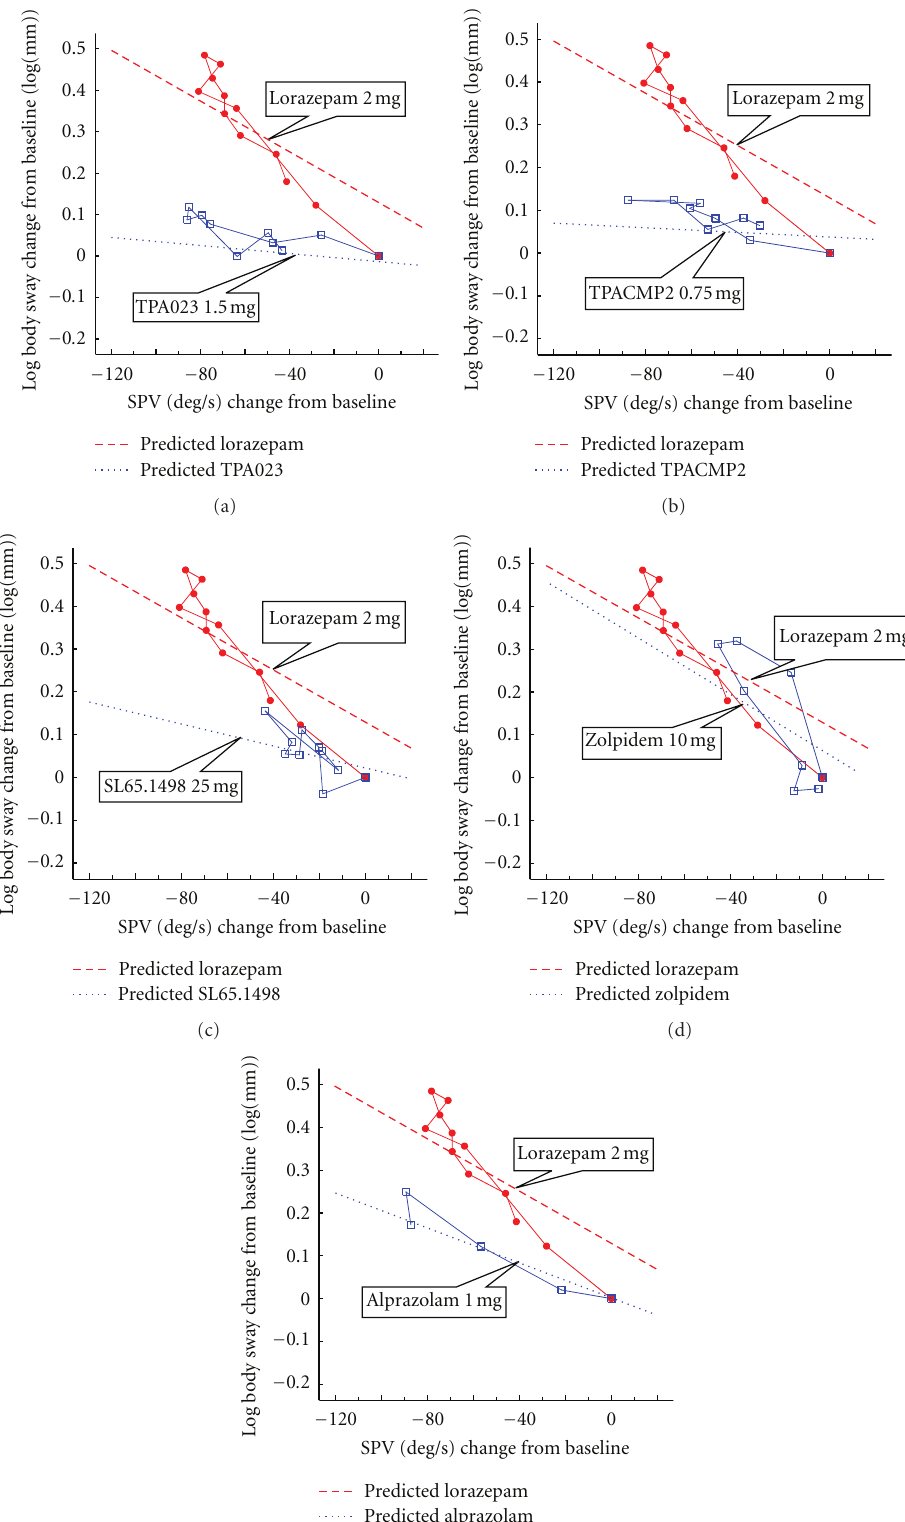
Figure 1: Δ LogSway (log mm)- Δ SPV (deg/sec) relative e ff ect profile of TPA023 1.5 mg, TPACMP2 0.75 mg, SL65.1498 25mg, zolpidem 10mg, and alprazolam 1mg versus lorazepam 2mg, respectively. (Blue open square: investigational compound; red closed circle: lorazepam 2mg; blue dot line: the comparator drug; red dash line: lorazepam